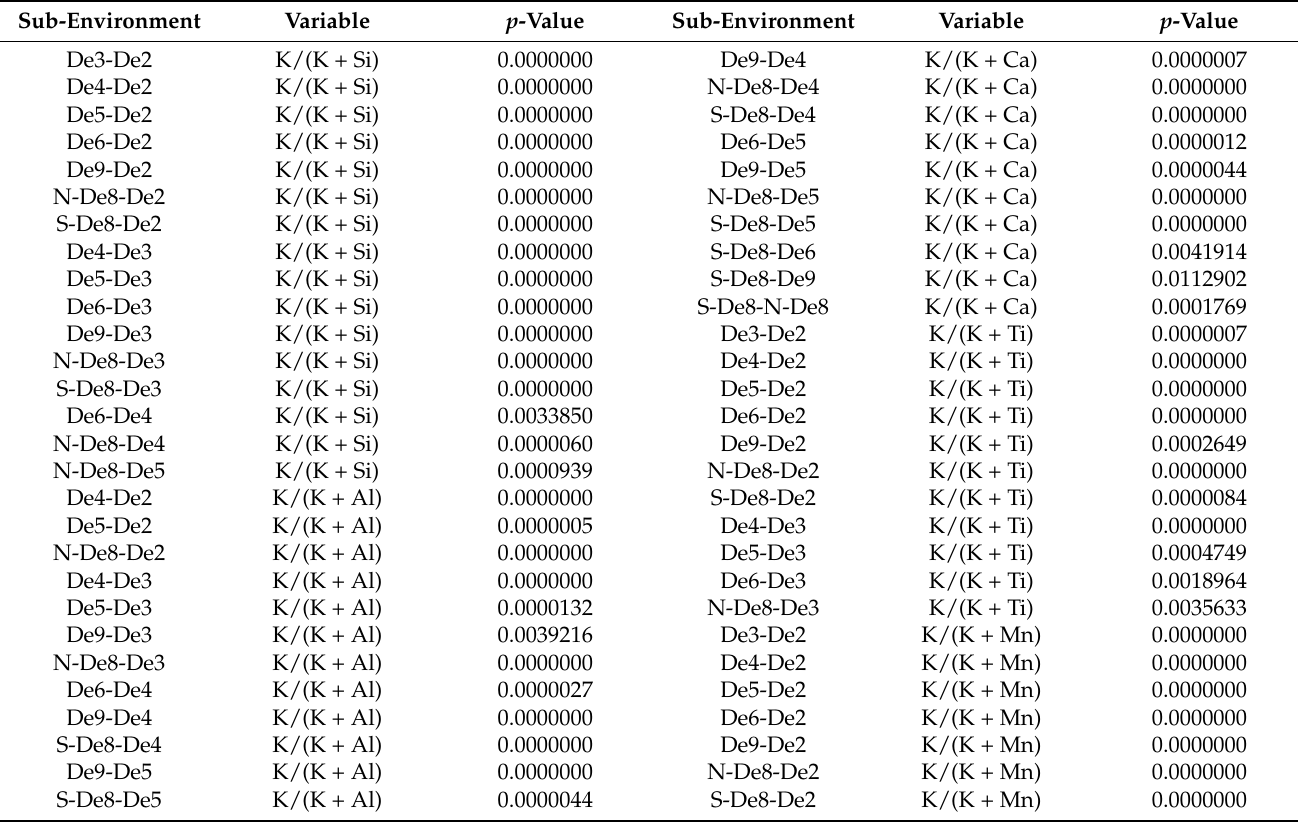
Table 4. Collation of some of the significance values resulting from the ANOVA analysis and Tukey’s post hoc honestly significant difference (HSD) tests for the sand-dominated sedimentary environments. The following symbols presented here highlight the statistical significance; significant when p < 0.05 (*), very significant when p < 0.01 (**), and extremely significant when p < 0.001 (***). We have excluded differences that are marginally significant (when p <